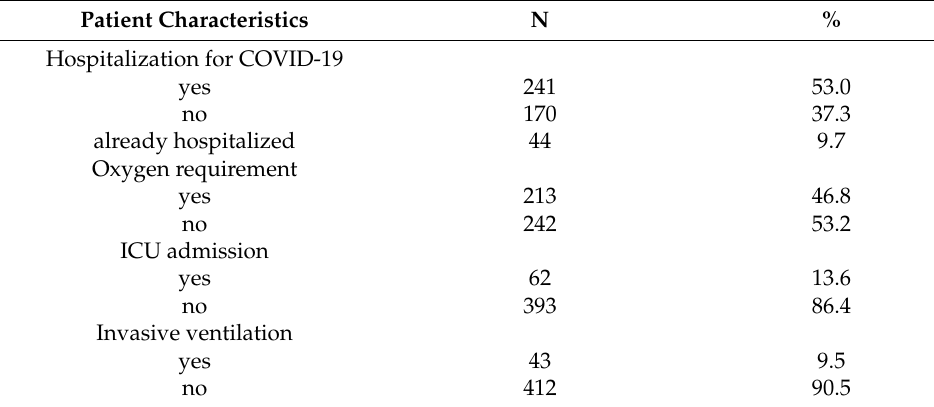
Table 2. SARS-CoV-2 infection outcome in cancer